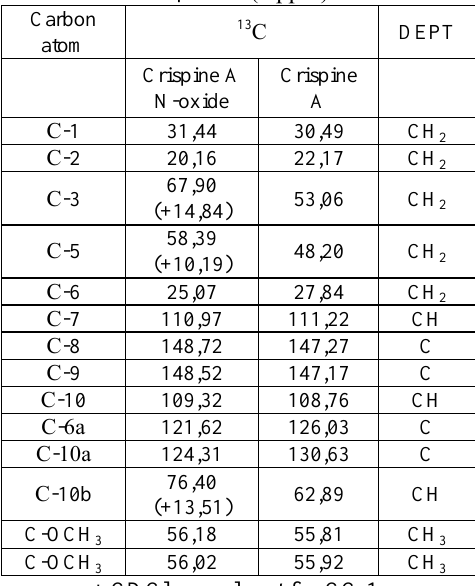
Table 1. 1 H and 13 C NMR (400MHz) and DEPT spectral data of Crispine A N-oxide and Crispine A (δ